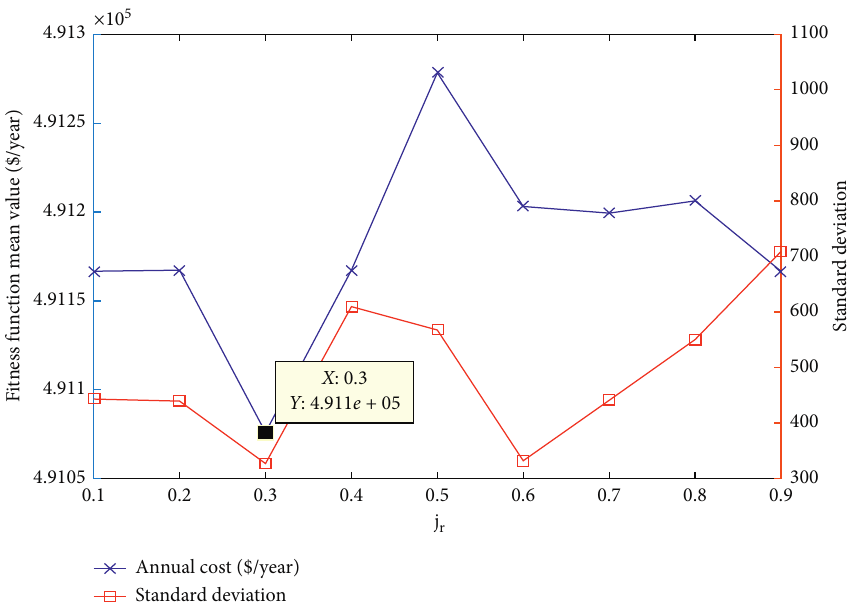
Figure 6: Influence of the jumping rate parameter j